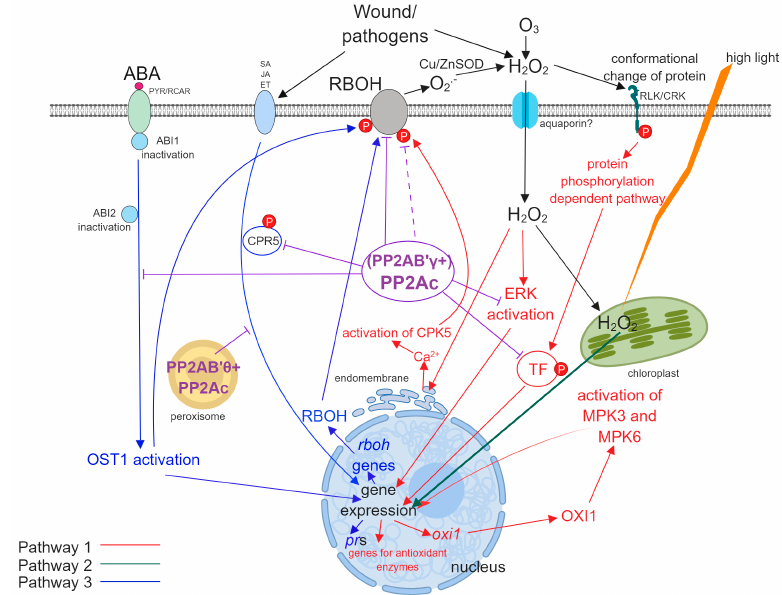
Figure 2. An overview of proven and hypothetical oxidative stress signaling pathways, where PP2A is involved. Red: Pathway 1; green: Pathway 2; Blue: Pathway 3. Clear lines / arrows show pathways that are already elucidated, while dashed lines / arrows show pathways for which some evidence exists, but further research is needed for clarification. The central player of these players is RBOH: the pathway of its expression and activation is controlled at multiple steps of Pathway 3 and it is also crucial for the production of apoplastic ROS, that will then re-enter Pathway 1 that is also controlled by PP2A. There is poor information on the regulation of Pathway 2 by PP2A. CPR5 is a phosphoregulated protein involved in SA signaling. CPK5 and ERK are Ca 2 + activated protein kinases. OST1 (OPEN STOMATA 1) is a protein kinase involved in the activation of RBOH. OXI1 is a Ser / thr kinase and RLK / CRK is a large family of receptor-like kinases. PYR / RCAR is the ABA receptor and ABI1 and ABI2 are the PP2Cs inactivated by ABA.